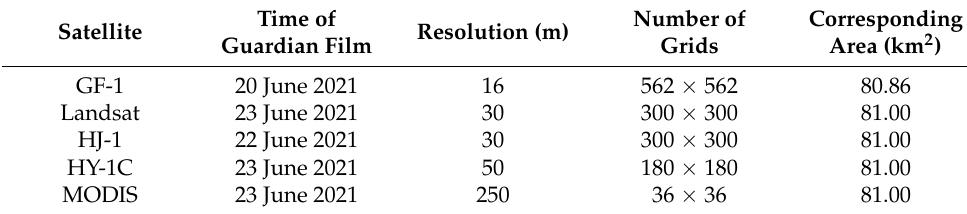
Table 3. Selection regions of the same area size from different data